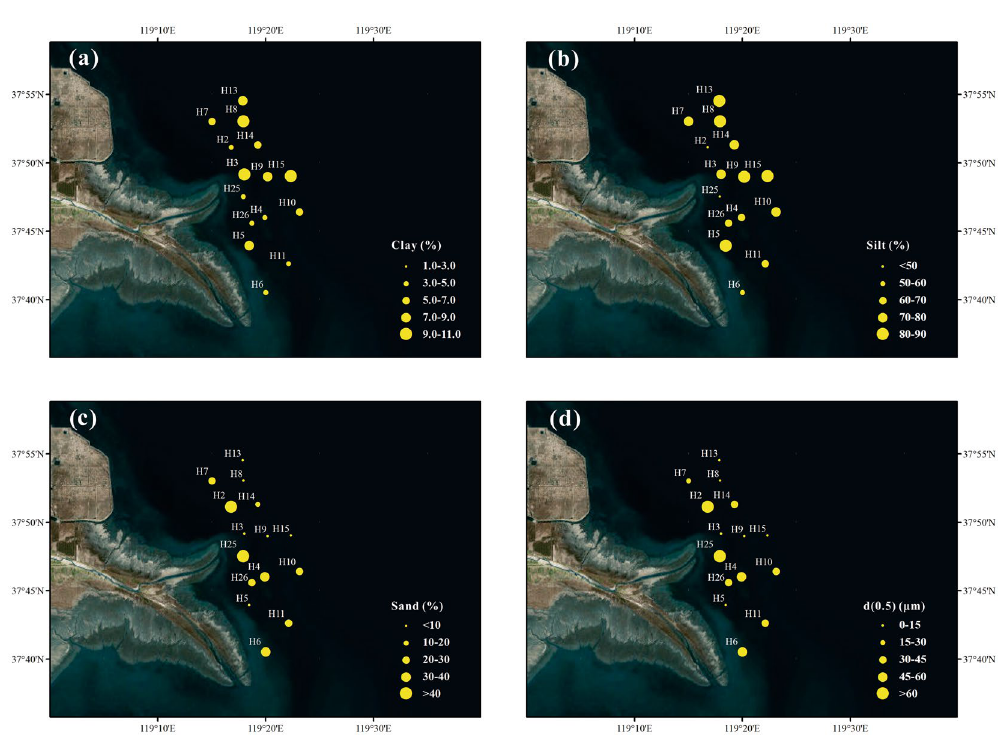
Figure 2. Distributions of (a) clay (%), (b) silt (%), (c) sand (%), (d) the median diameter (d(0.5), µ m) in surface sediments of the Yellow River Estuary. The maps were generated by ArcGIS 10.2 (http://www.esri.com/